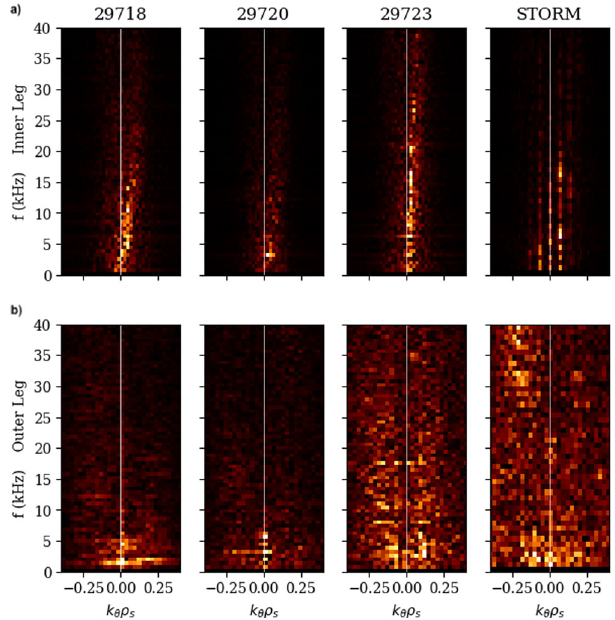
Fig. 4 Turbulent spectra in inner and outer divertor legs. Wavenumber (relative to larmor radius) and frequency spectra from the ψ N = 0.99 surface from the inner (row a ) and outer (row b ) divertor legs where ψ N is the normalised poloidal fl ux coordinate. Three experimental examples are provided from the database outlined in table 1 alongside the simulation in the four columns as labelled. All data are shown on a consistent, arbitrary linear